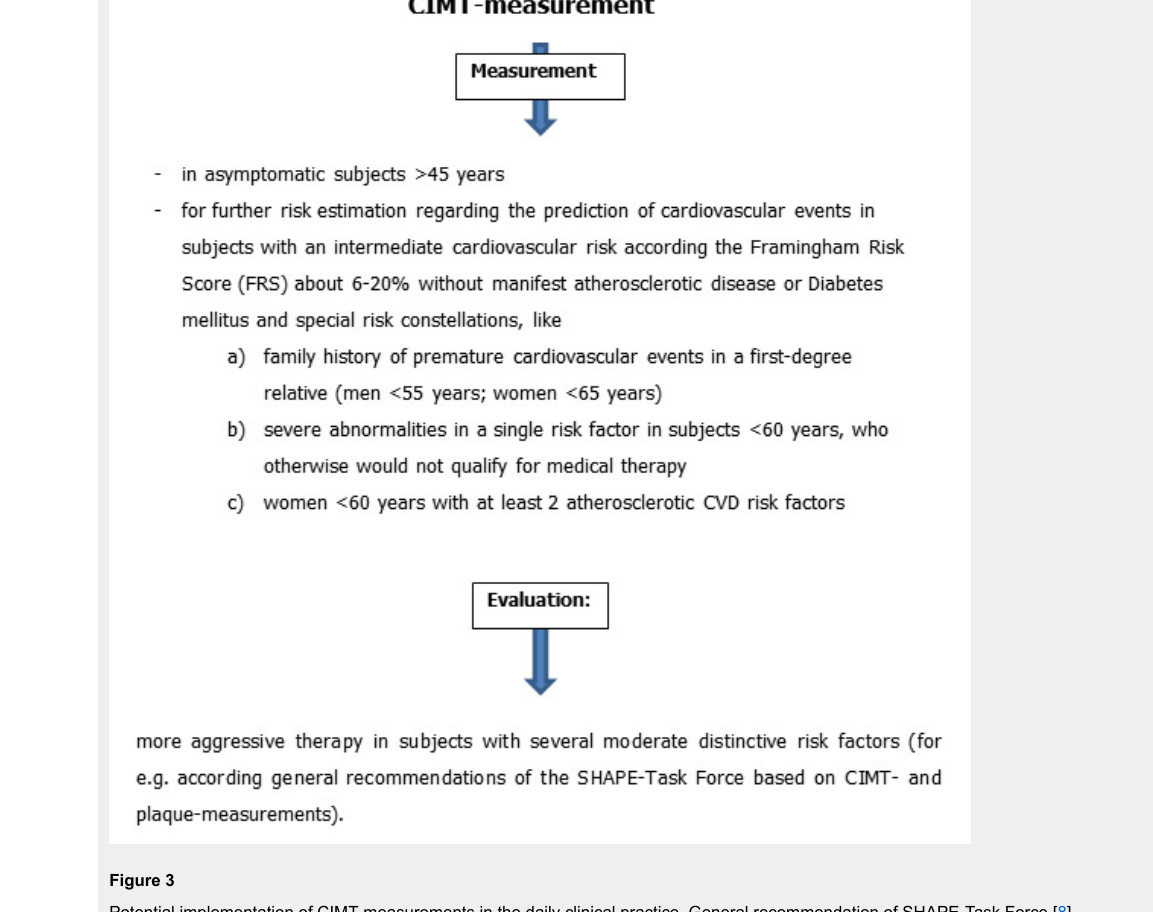
Figure 3 Potential implementation of CIMT-measurements in the daily clinical practice. General recommendation of SHAPE-Task Force